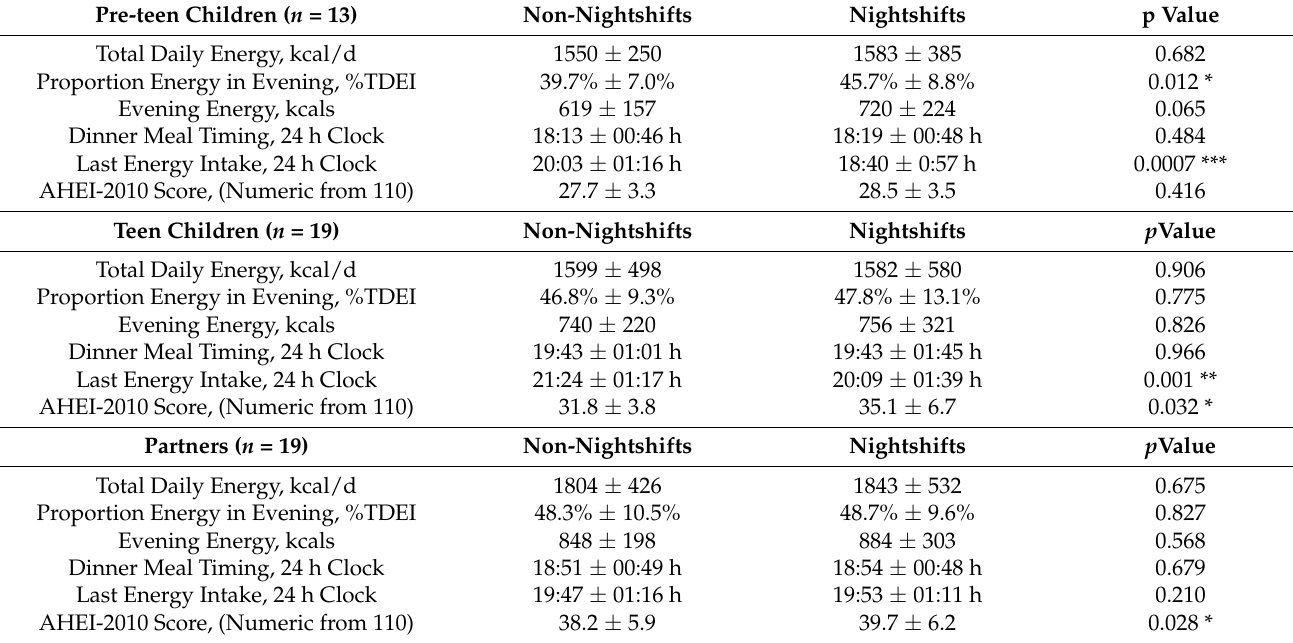
Table 1. Dietary Intake of Children During Maternal Nightshift Work vs. Non-Nightshifts.